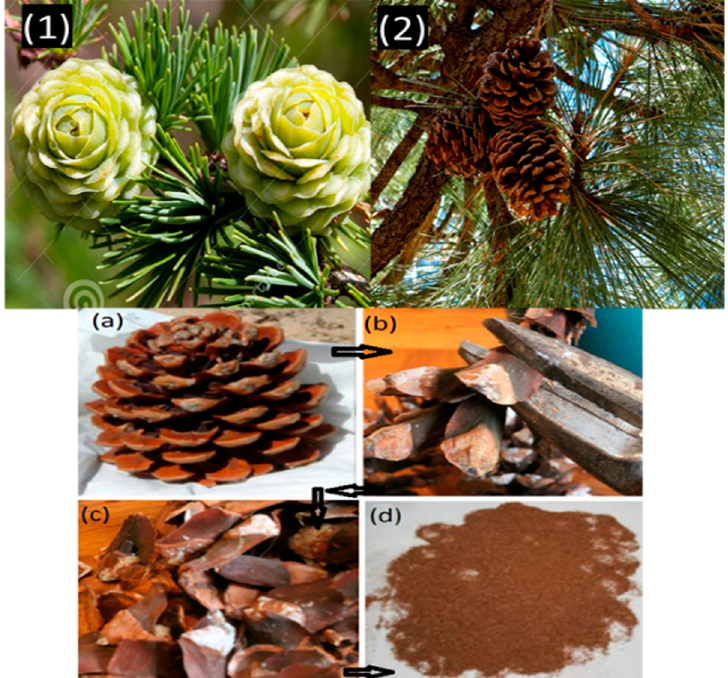
Figure 1. Pine cone flowers in their natural state ( 1 , 2 ) and extraction of pine cone fibres ( a – d ).